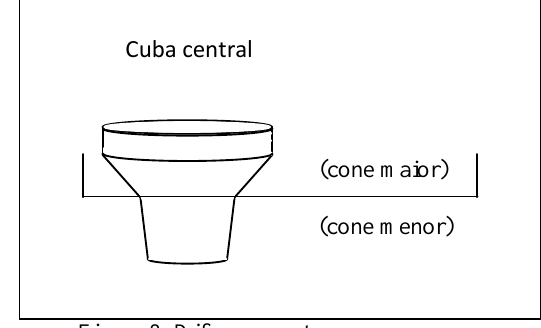
Figura 8. Diferença entre os